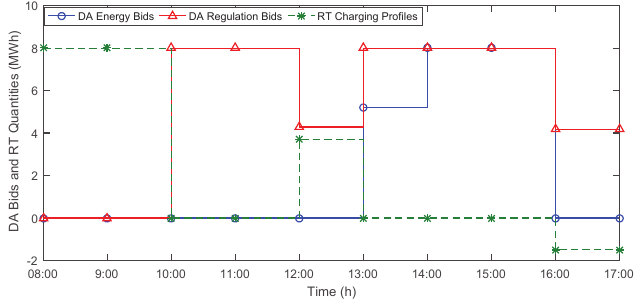
Figure 8. Optimal results in the DA market under M2.